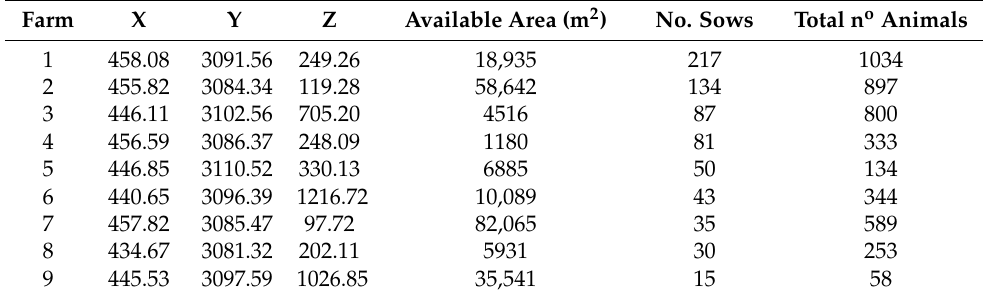
Table 1. Selected livestock farm